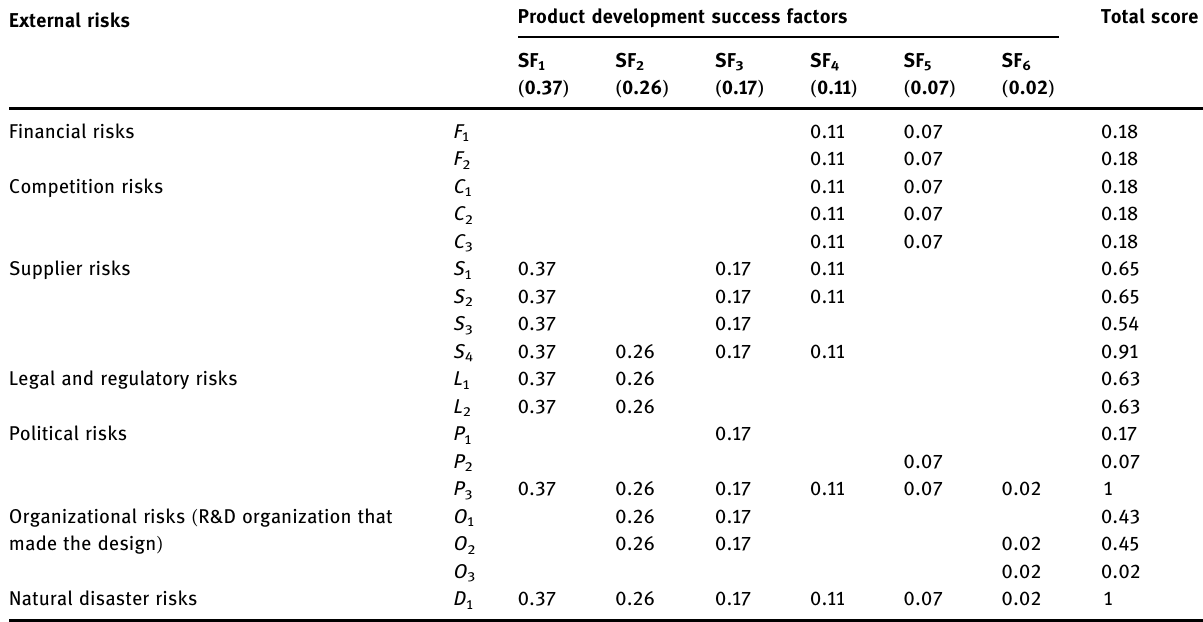
Table 9: Calculation of total scores of